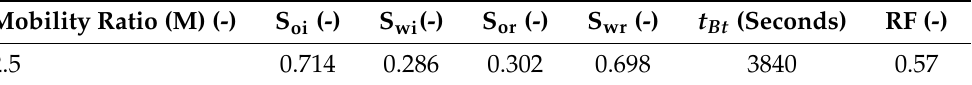
Table 1. Overview of the parameters determined from experimental results. Mobility Ratio (M)